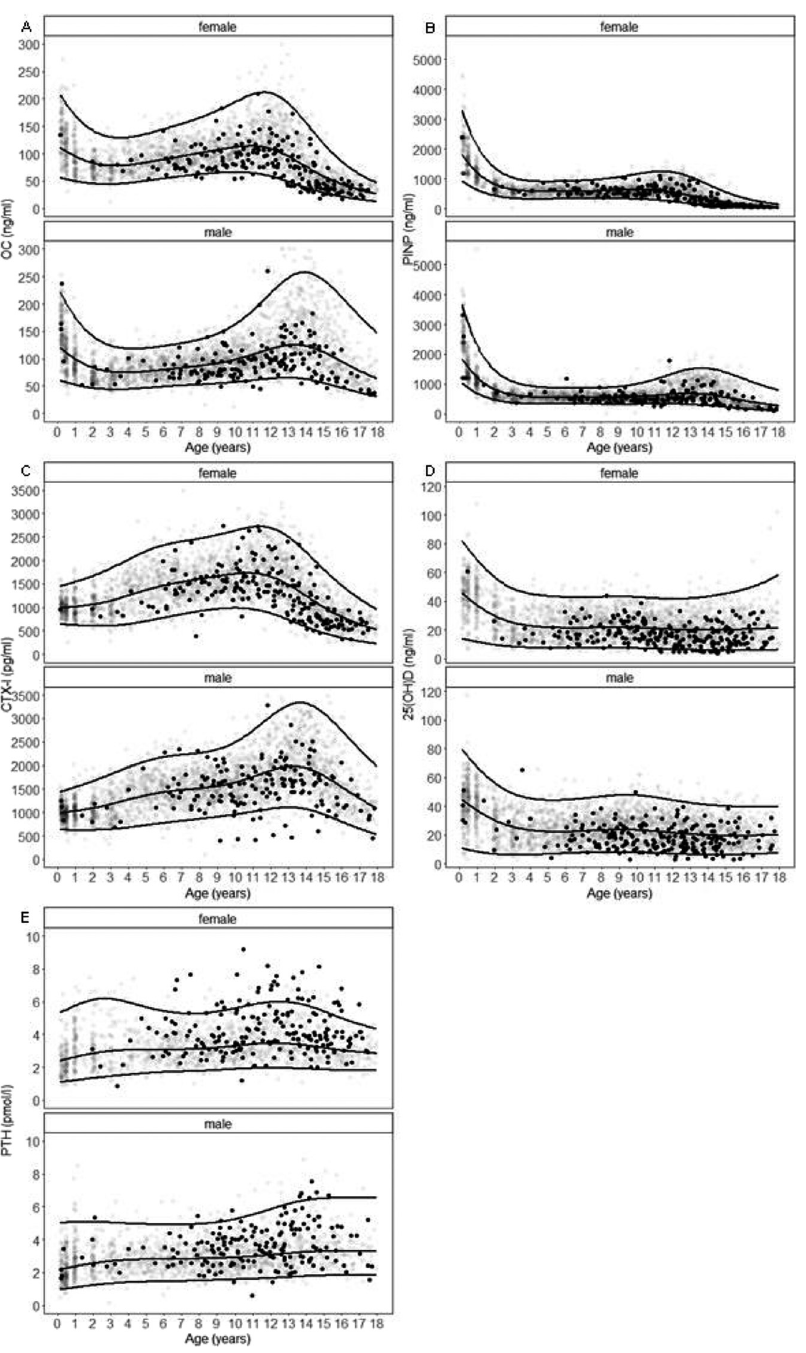
Figure 4: Percentiles for osteocalcin (OC), PINP, CTX-I, 25(OH)D, and PTH by age and gender. Boys ’ and girls ’ percentiles are shown (2.5th,50th,97.5th)fortheOC(A),PINP(B), 459 CTX-I (C), 25(OH)D (D), and PTH (E) levels in the reference cohort (transparent dots), and the distribution of levels for obese children (BMI-SDS >1.88) are shown as black dots. With permission from ref.